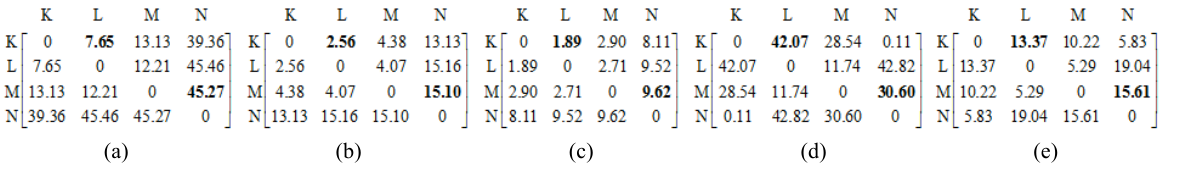
Figure 5. Relative similarity values of four trajectories: (a) Latitude and longitude (2D); (b) Latitude, longitude, and altitude (3D); (c) Latitude, longitude, altitude, airplane speed, and airplane heading; (d) Wind speed and wind direction; (e) All the